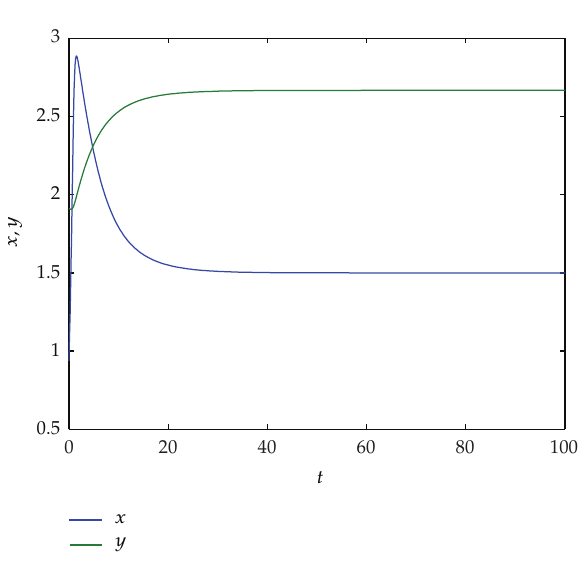
Figure 2: The positive equilibrium E ∗ of system (cid:4) 2.1 (cid:5) is globally asymptotically stable.